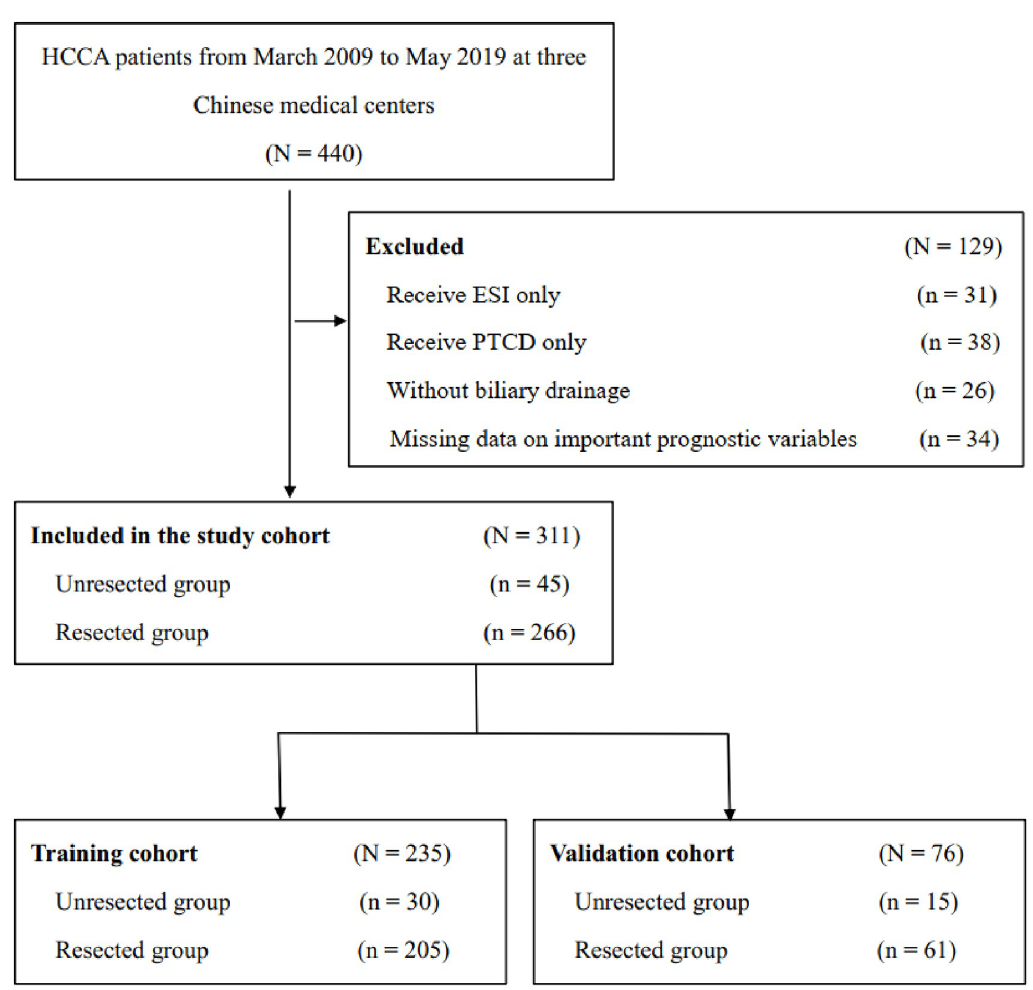
Fig 1. Selection of the study population. HCCA, hilar cholangiocarcinoma. ESI, endoscopic stent implantation. PTCD, percutaneous transhepatic cholangial drainage.